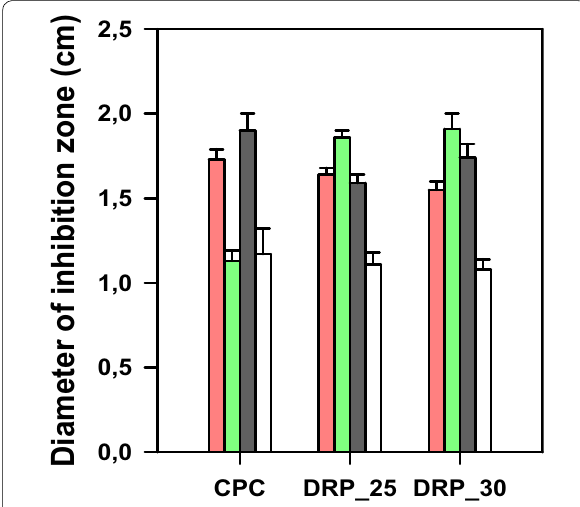
Fig. 4 Effect of protein added on the antibacterial activities of Aeromonas hydrophila (red bar), Bacillus cereus (green bar), Escherichia coli (grey bar), and Staphylococcus aureus (white bar). C‑PC is the positive control, while DRP_25 and DRP_30 represent to samples incubator at 25 °C and 30 °C, respectively. All the proteins concentrations are the same as 0.25 mg